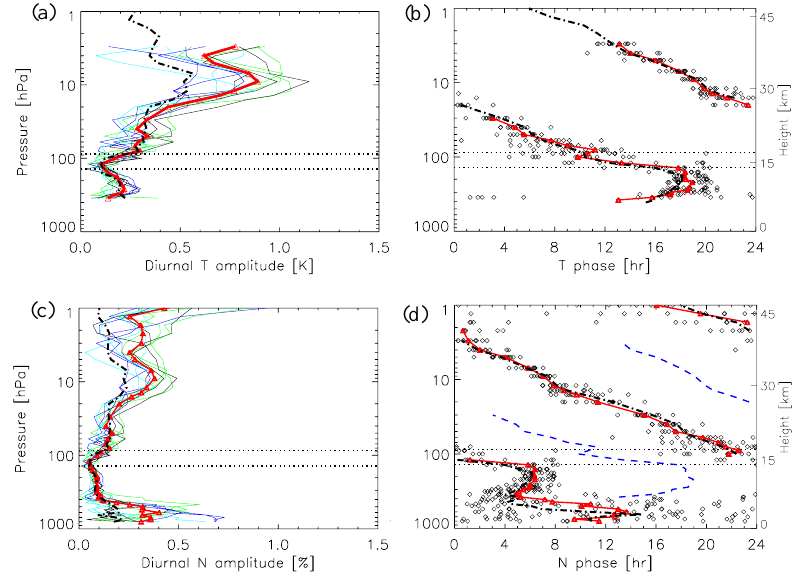
Fig. 1. Vertical structure of the temperature (a, b) and refractivity (c, d) amplitude (left panels) and phase (right panels) of diurnal variations over 10 ◦ S–10 ◦ N based on COSMIC RO observations in 2007. Each solid line (a, c) represents one monthly mean amplitude profile whereas phases from the monthly data are shown as open diamond (b, d). The four seasons are denoted by different colors in (a) and (c) , e.g., DJF (green), MAM (blue), JJA (cyan), SON (black). The RED thick lines show the annual median values. The blue dashed lines in (d) represents the temperature phase as shown in (b) . The black dash-dot lines in all four panels correspond to the annual median-averaged results derived from the UCAR retrievals in 2007. The two black thin dashed lines in each panel mark the altitudes at 14km and 17km, respectively. 4 Seasonal variations